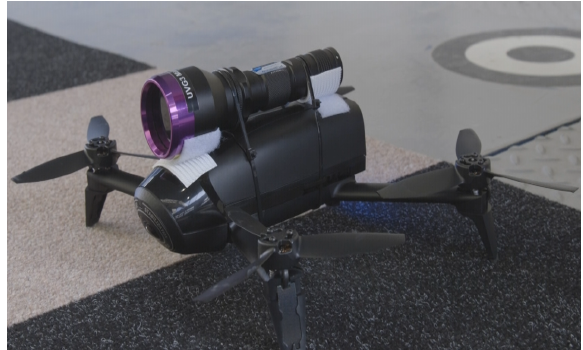
Figure 1. The aerial vehicle used in the proposed inspection methods.